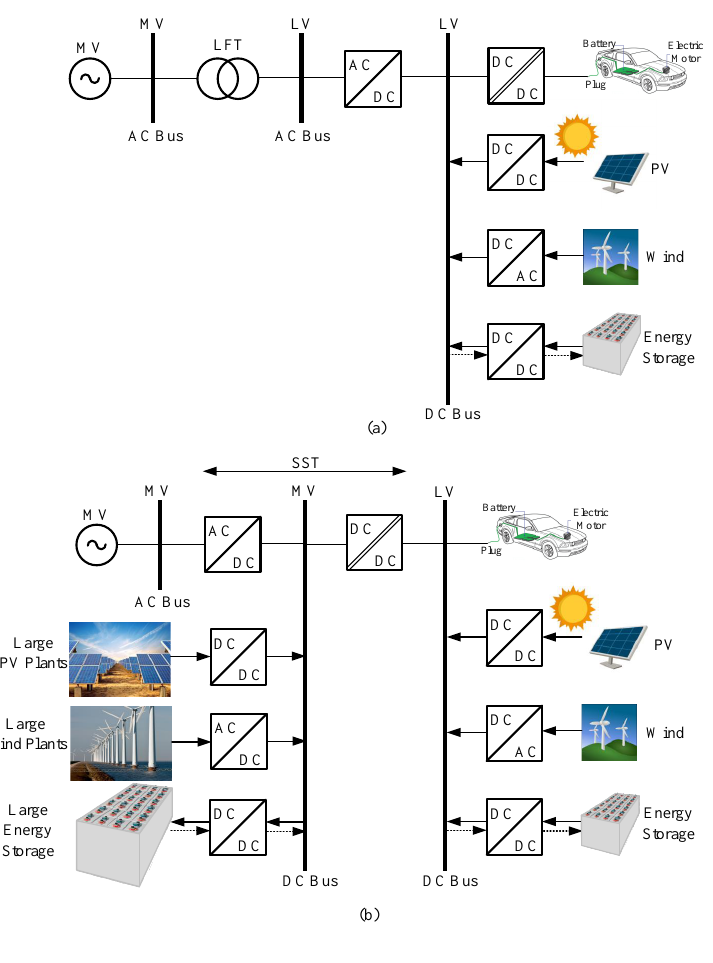
Figure 1. The ultra-fast charging stations: ( a ) DC LFT-based ultra-fast charging station; ( b ) DC SST-based ultra-fast charging station. Table 1. A comparative analysis of DC LFT-based and SST-based ultra-fast charging